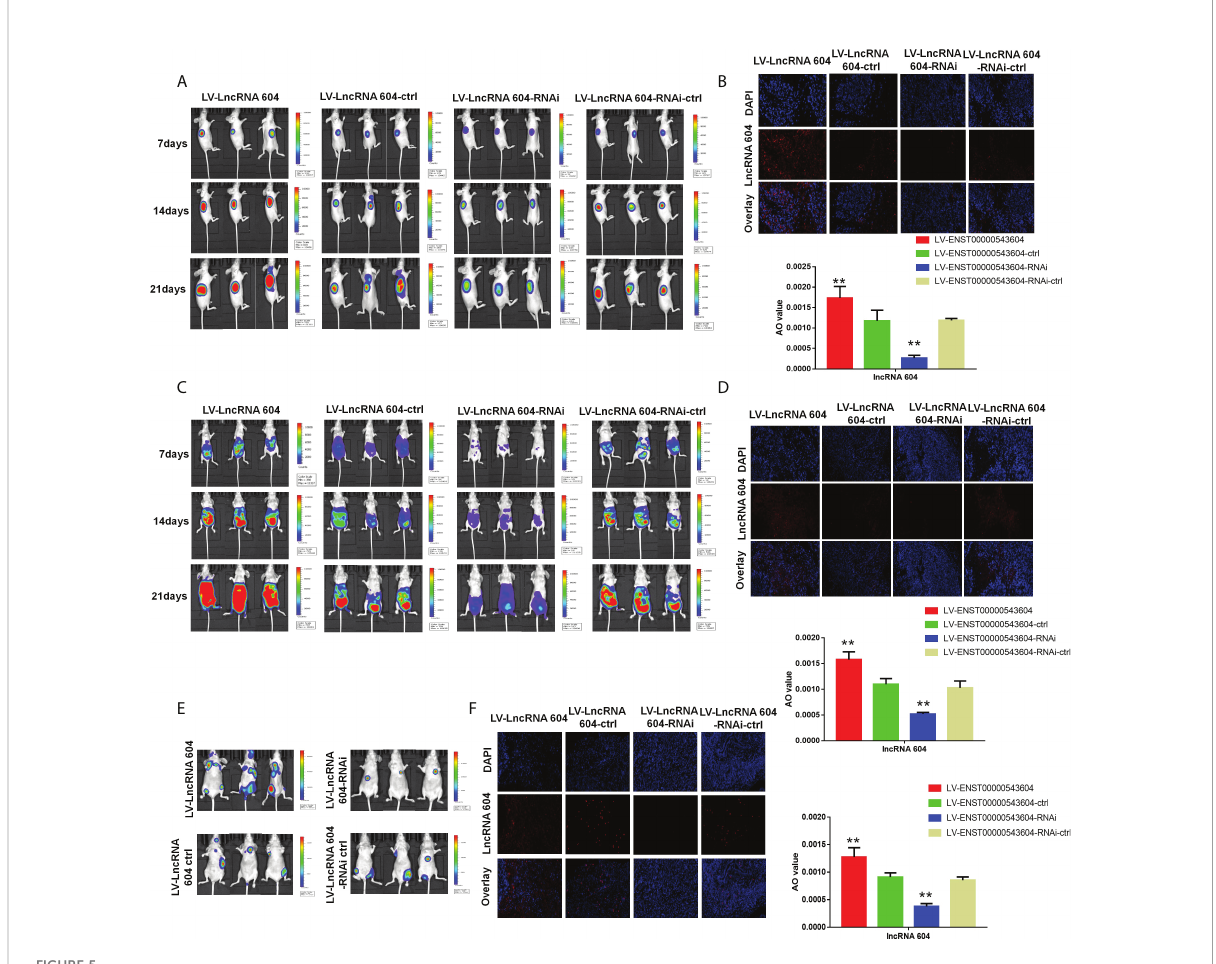
FIGURE 5 LncRNA 604 promoted CRC cell growth and metastasis in vivo. (A) The growth of subcutaneous tumor was observed in every group by a small- animal living imaging system: tumour growth increased in LV-lncRNA 604 group, however suppressed in LV-lncRNA 604-RNAi group. (B) The expression of lncRNA 604 in the xenograft tumors was detected by FISH (magni fi cation 50×). (C) Much more metastases were found in LV- lncRNA 604 group, however the LV-lncRNA 604-RNAi group was opposite in abdominal cavity metastasis model. (D) The lncRNA 604 expression of abdominal metastases was consistent with cells (magni fi cation 50×). (E) In the tail vein metastasis model, there were more multiple metastases in LV-lncRNA 604 group, however LV-lncRNA 604-RNAi group was signi fi cantly less than respective control group. (F)